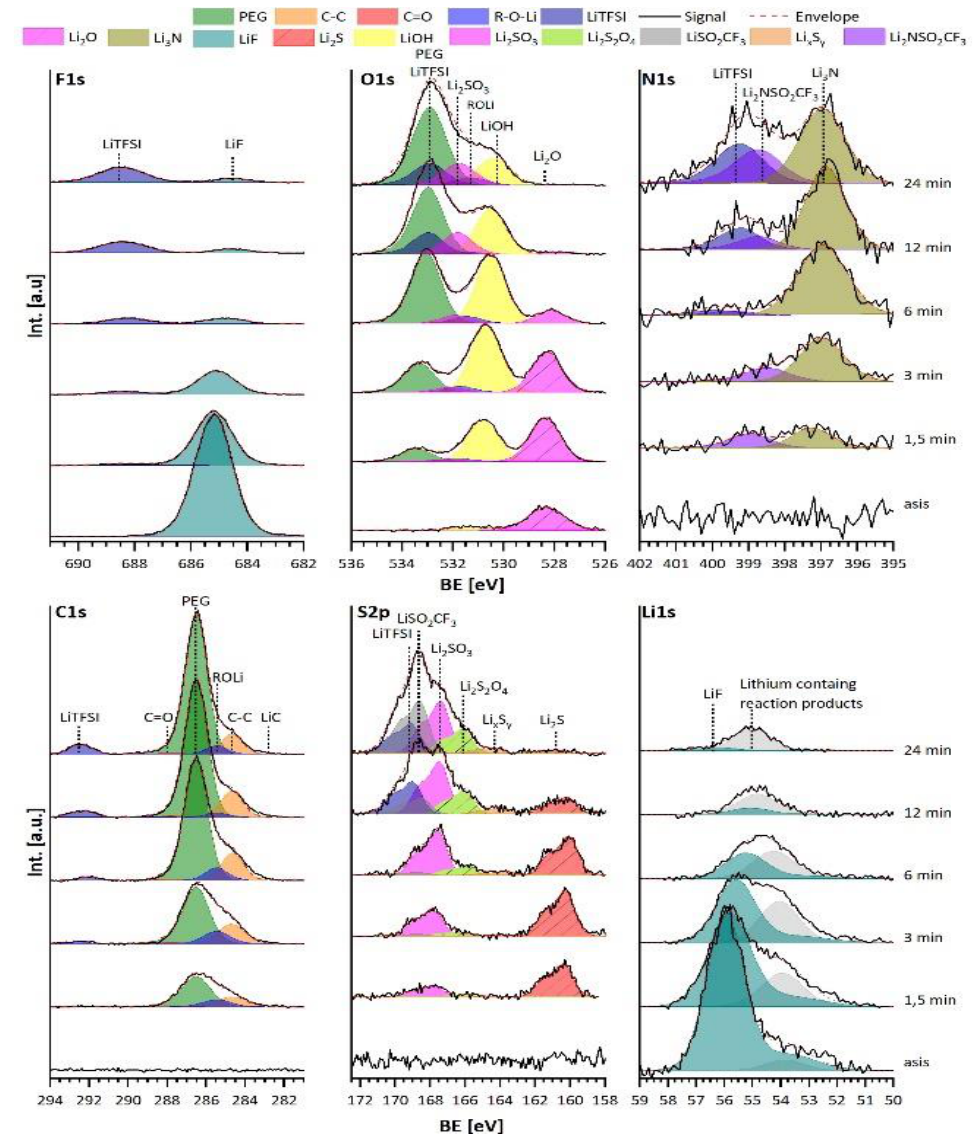
Figure 5. F1s, O1s, N1s, C1s, S2p, and Li1s XP spectra of the interface between LiF and PEG+LiTFSI, with deposition times from 1.5 min up to 24 min.